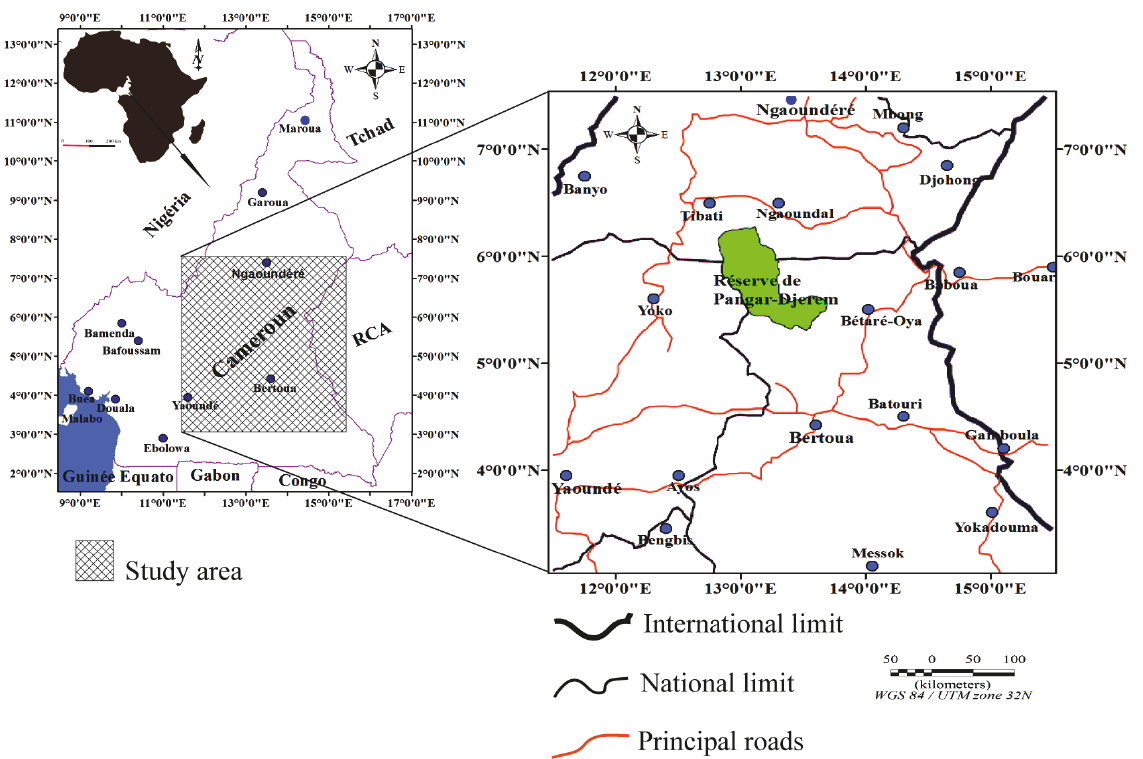
Figure 1: Localization of the study